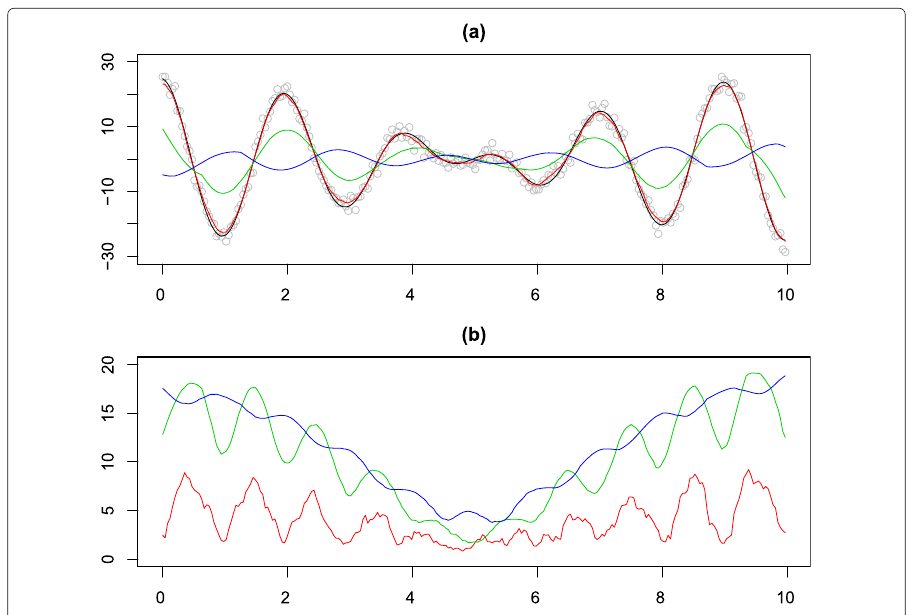
Fig. 5 a Noisy sequence (open circles), true function (black line), Ave τ t ( X t ) by τ = 8 (red line), τ = 32 (green line), τ = 64 (blue line), and b sd τ t ( X t ) by τ = 8 (red line), τ = 32 (green line), τ = 64 (blue